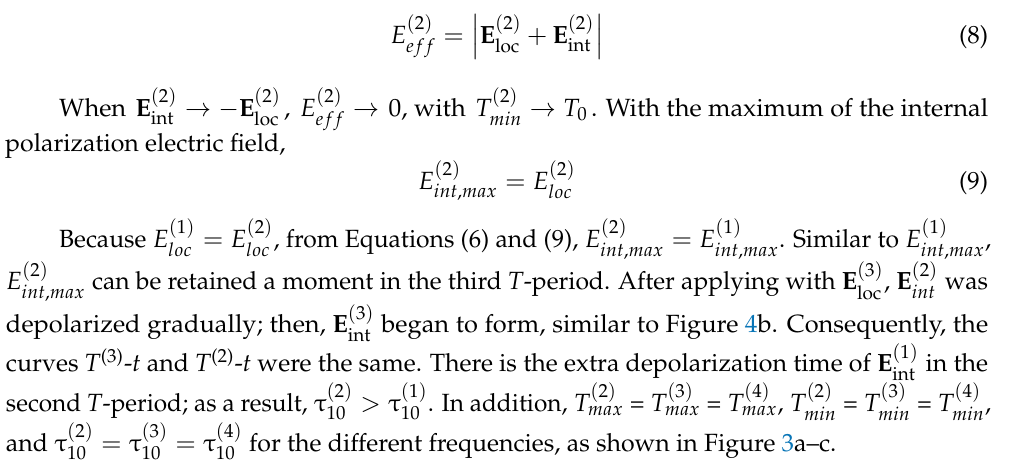
loc(1) int(1) ; ( b ) 𝐄 loc(2) and ( d )